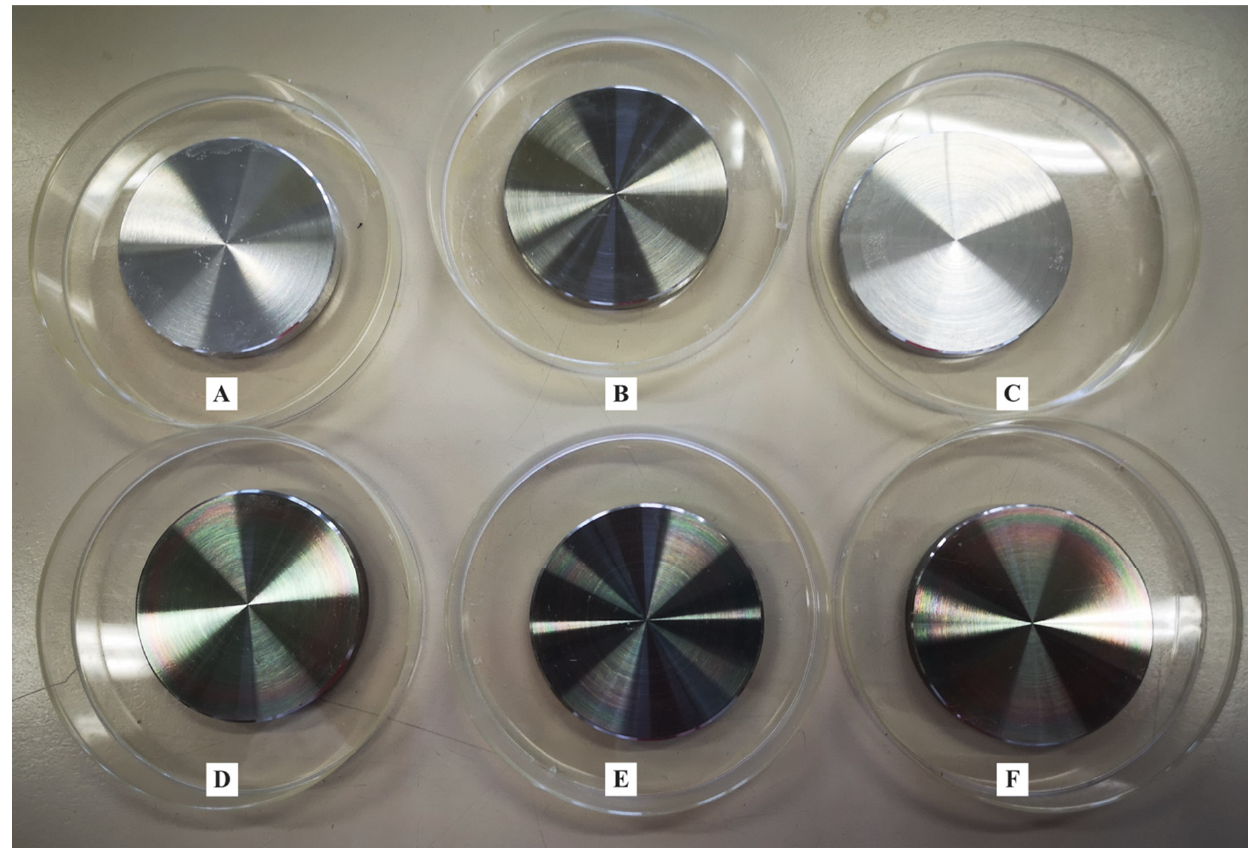
Figure 8. Representative image of stainless-steel disks of different R a ( A – C ) uncoated and ( D – F ) SiO x C y H z -coated. ESEM images of the uncoated and SiO x C y H z -coated stainless-steel disks, along with their respective X-EDS microanalysis, are reported in Figure